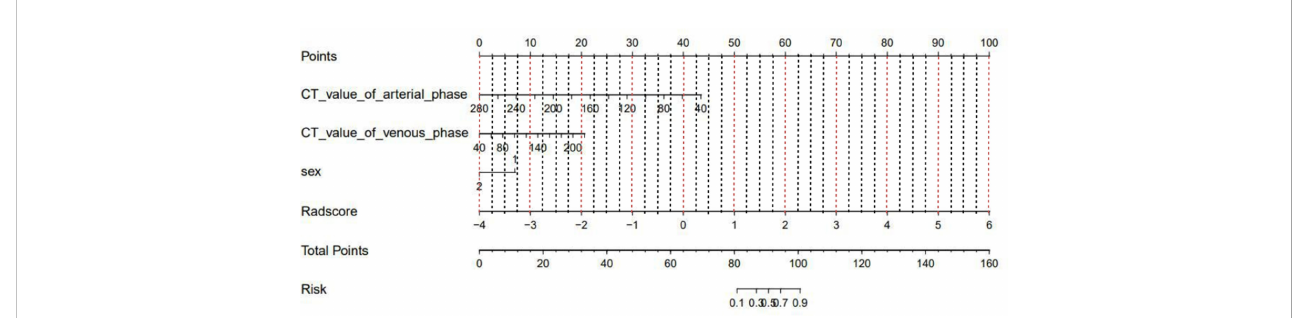
FIGURE 9 Nomogram of model 4 constructed by combining clinical risk factors and CT radiomics